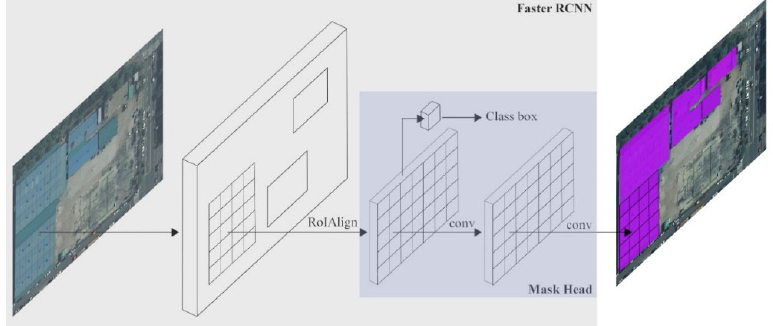
Figure 3. The mask RCNN framework for instance segmentation.